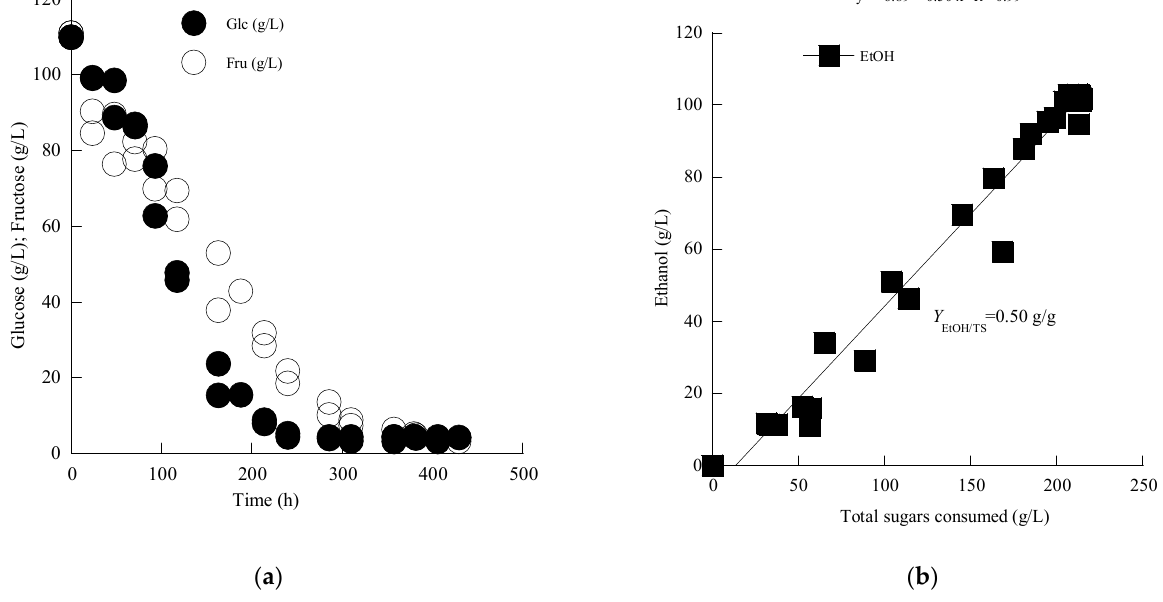
Figure 2. ( a ) Kinetics of glucose (Glu) and fructose (Fru) of the S. cerevisiae Passion Fruit strain in must from the grape variety Assyrtiko. Each experimental point is the mean value of 2 independent measurements (SE for most experimental points ≤ 17%). ( b ) Representation of ethanol produced vs. total sugars consumed of the S. cerevisiae Passion Fruit strain in must from the grape variety Assyrtiko. for the whole set of data. Each experimental point is the mean value of 2 independent measurements (SE for most experimental points ≤ 17%).